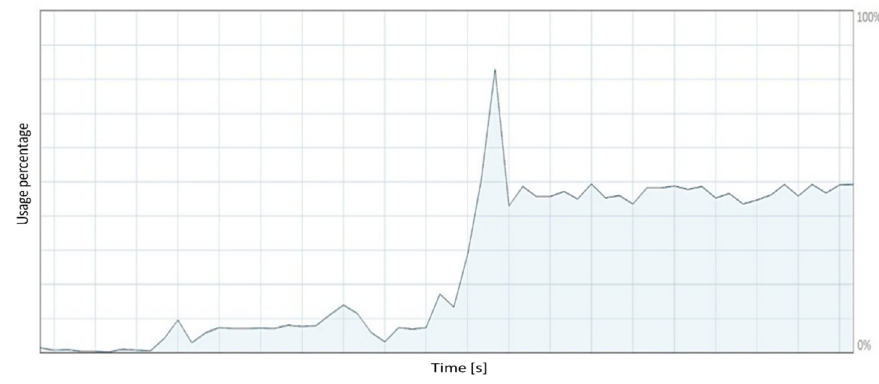
Figure 26. GPU performance.